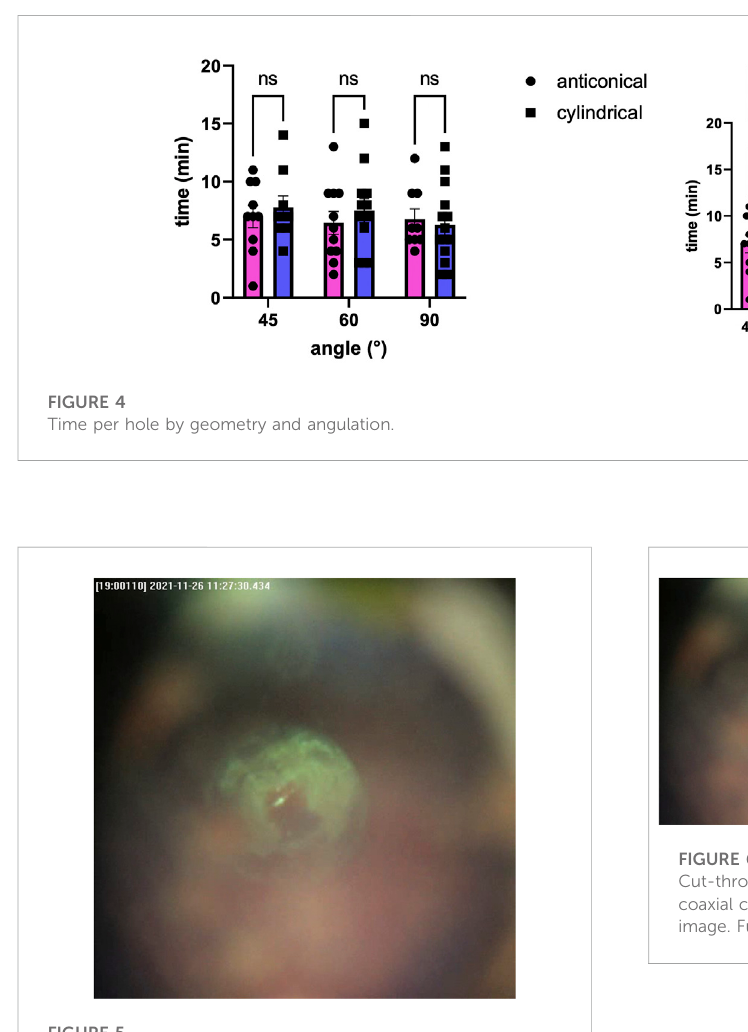
FIGURE 5 Cut-through detection with the live-feed coaxial camera system.